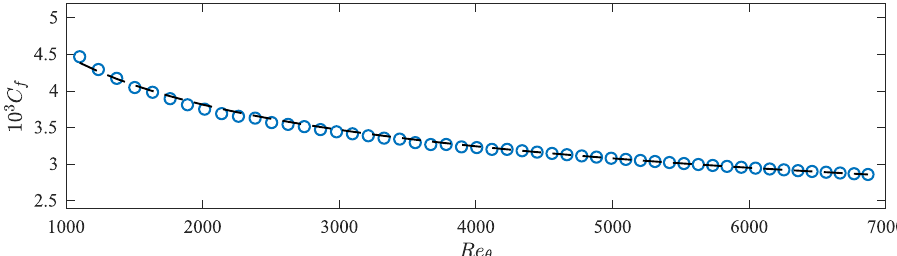
Fig. 5 Predicted friction coef fi cients for the turbulent boundary layer. Friction coef fi cient C f as a function of Re θ . Symbols are LLWM and line is the empirical C f 49 .